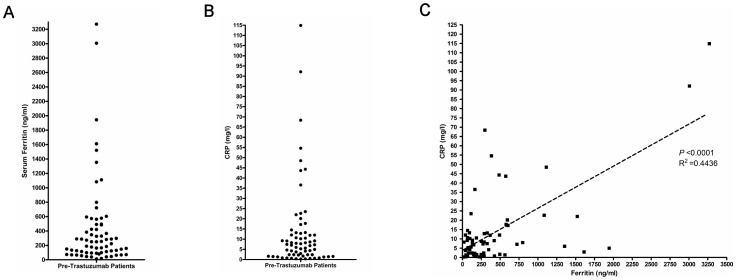
Serum ferritin (A) and CRP (B) levels in HER2/neu-overexpressing patients before undergoing trastuzumab-containing therapy (n = 66).The pretreatment values were moderately correlated (C).